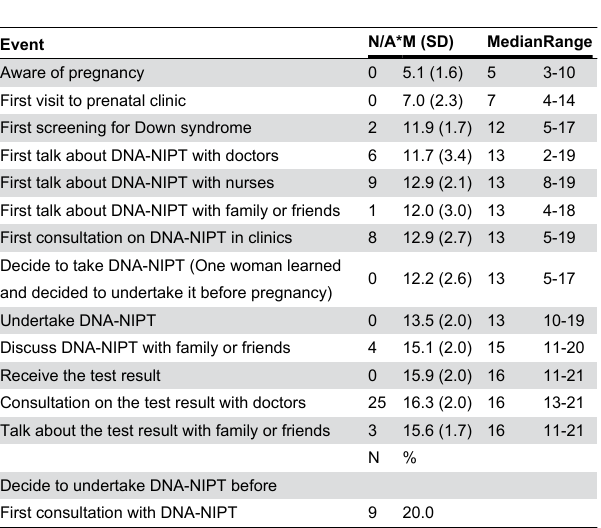
Table 2. Milestones of clinical pathway of DNA-NIPT for Down syndrome (weeks of